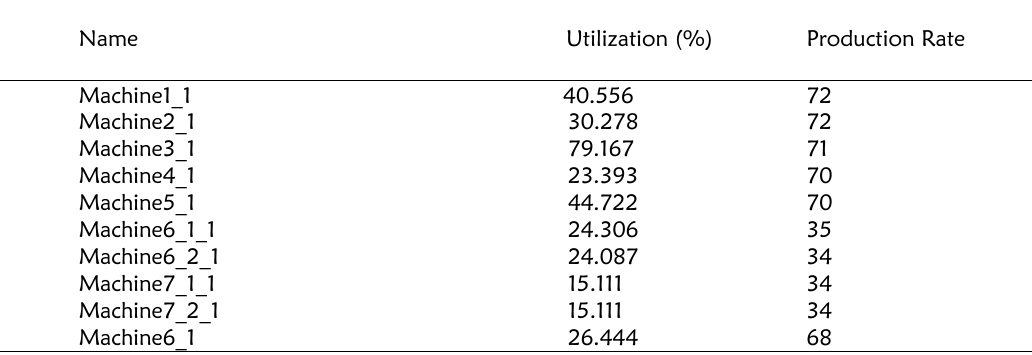
Table 1: Utilization and production rate for the manual handling system